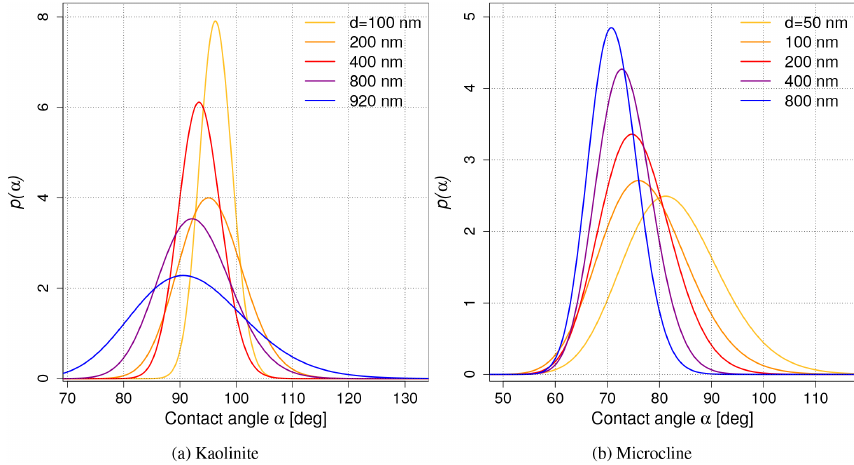
Figure C2. Change of α -pdf with particle size for the kaolinite and microcline dataset. The residence time is